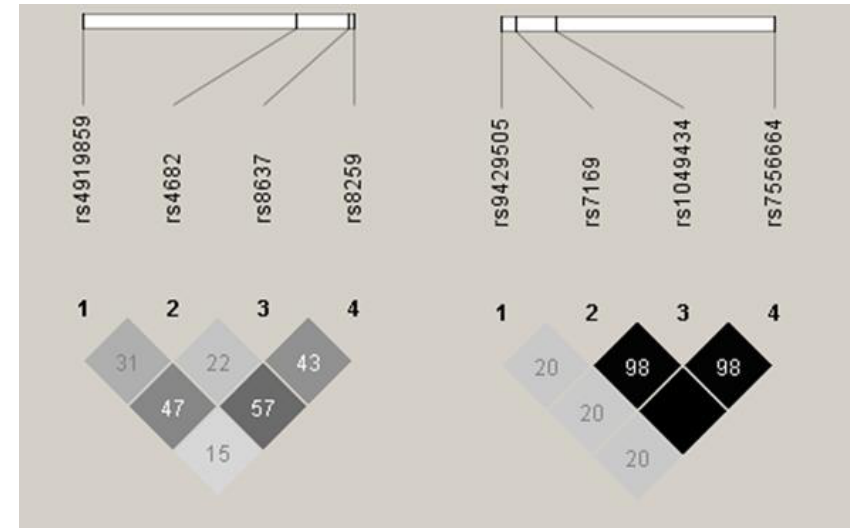
Figure 1. Linkage disequilibrium (LD) between single nucleotide polymorphisms (SNPs) under study. Basigin ( BSG) SNPs are shown to the left, and monocarboxylic acid transporter 1 ( SLC16A1, MCT1) to the right. Darker colour shows higher r 2 values, while the value shown inside the squares is r 2 × 10 2 . Results as presented by the Haploview 4.2 software